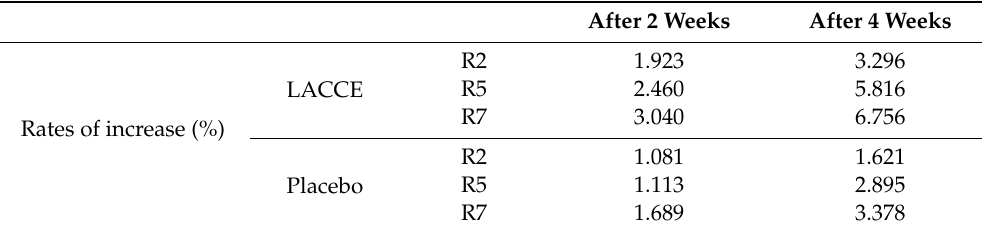
Table 3. Rates of increase in skin elasticity parameters (%).